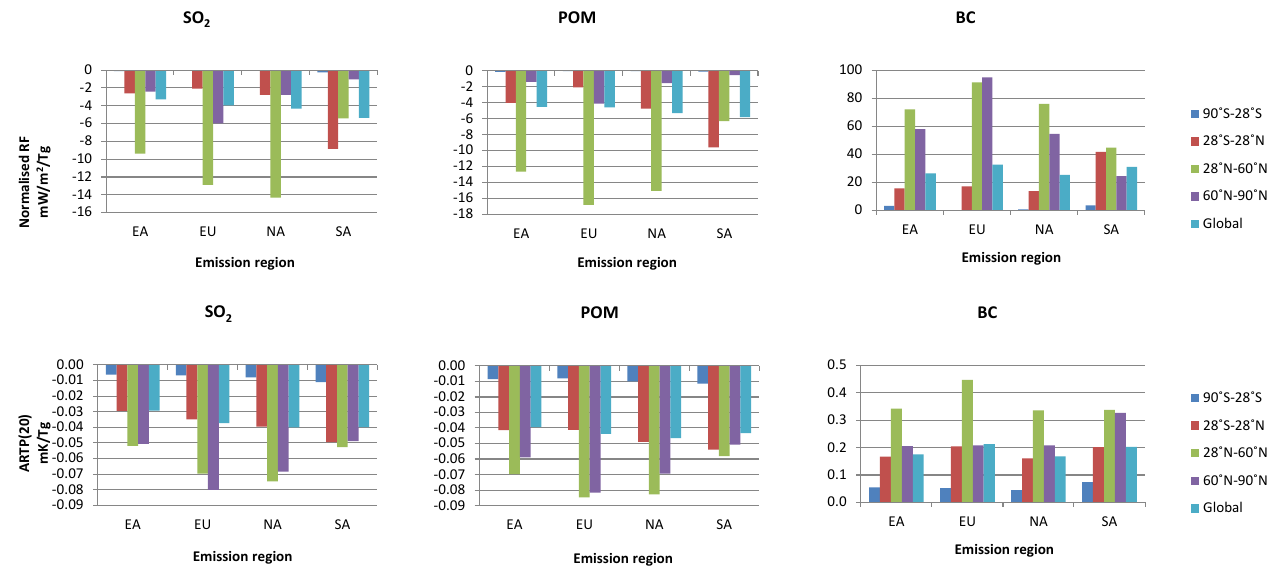
Fig. 5. Normalised equilibrium forcing in mWm − 2 Tg − 1 (upper panel) and ARTP(20) in mKTg − 1 (lower panel) for emissions of SO 2 , POM and BC from the four HTAP continents. The coloured columns represent the forcing and temperature response in 4 different latitude bands (90 ◦ S–28 ◦ S, 28 ◦ S–28 ◦ N, 28 ◦ N–60 ◦ N, 60 ◦ N–90 ◦ N) and globally.